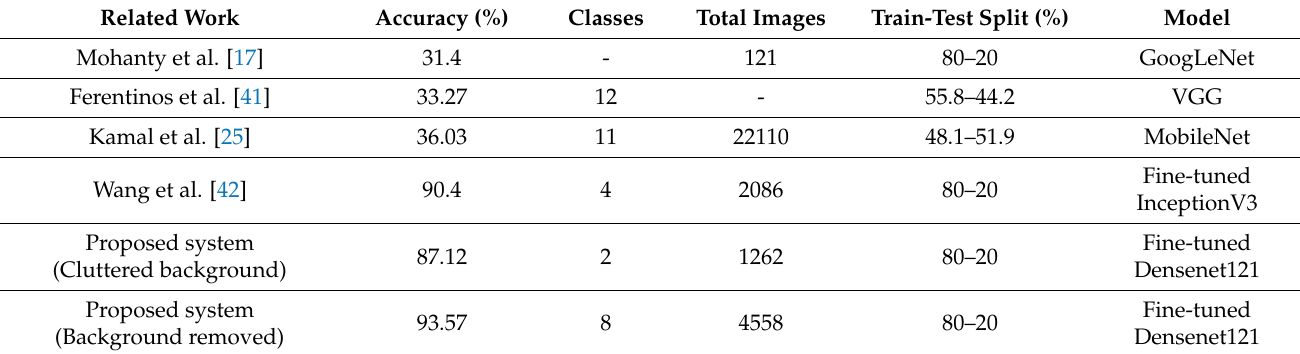
Table 3. A comparison of different CNN networks employed to classify plant disease with the proposed network.